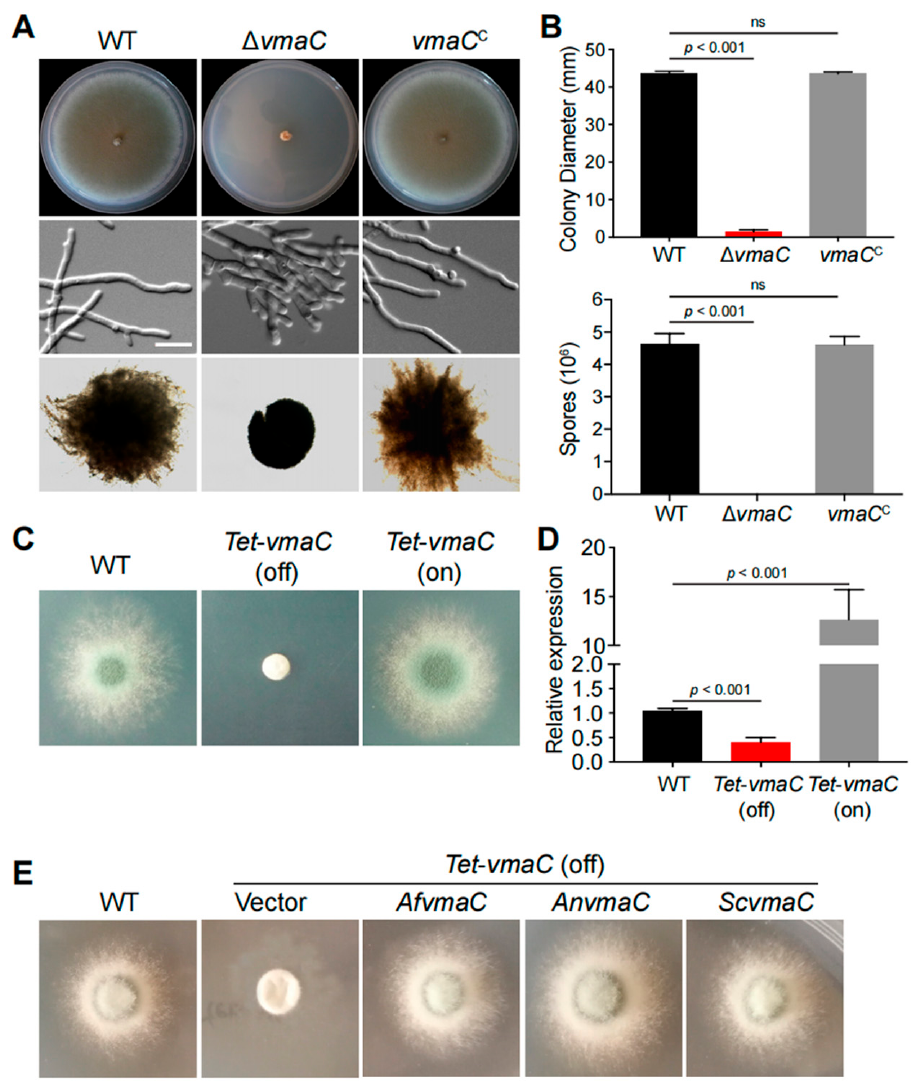
tested phenotypes were restored to the status of the WT strain under both solid and liquid culture conditions, indicating that VmaC is required for hyphal growth and conidiation.